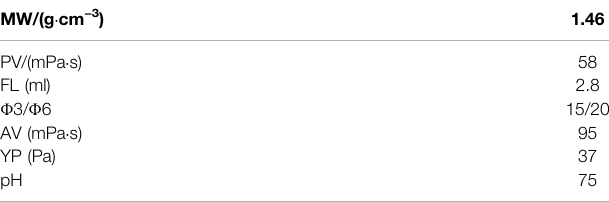
TABLE 1 | Basic properties of PEM drilling fl uid. TABLE 2 | Factor level table.